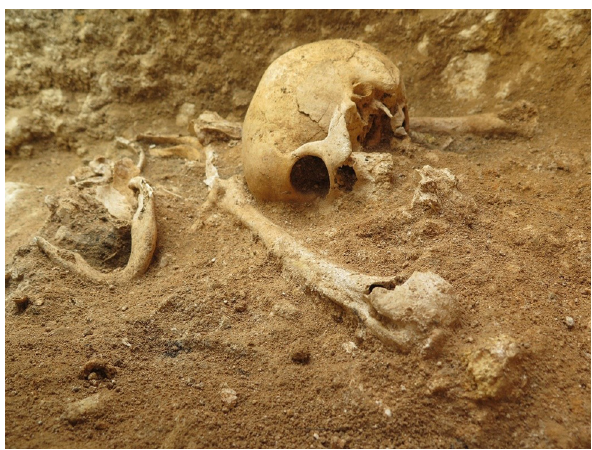
Figure 6: Detail of Skeleton 5 in early phase